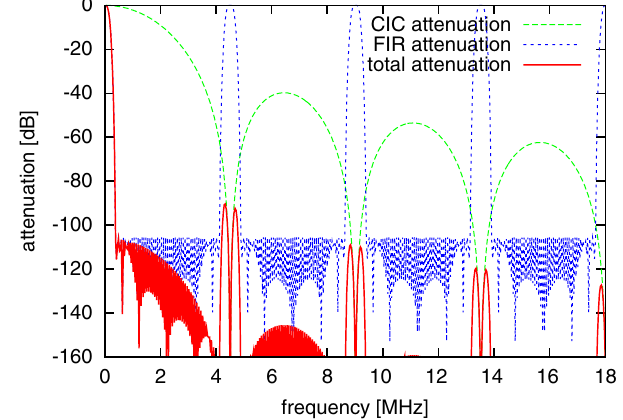
FIG. 9. (Color) Frequency response of the LPF in the harmonic- detection block.